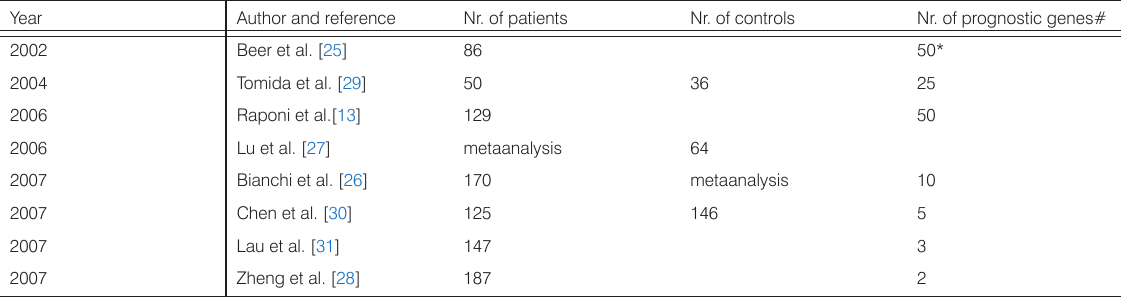
Table 1. The number of NSCLC prognostic markers identified by studies performed between 2002 and